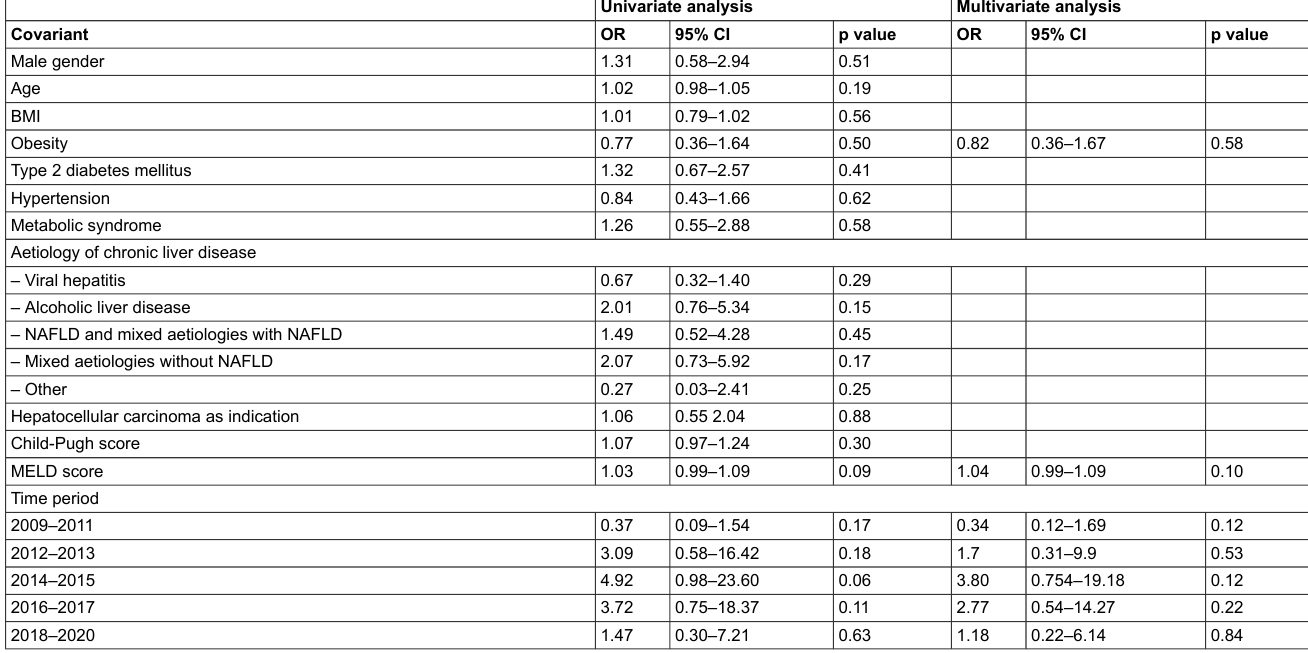
Univariate analysis Multivariate